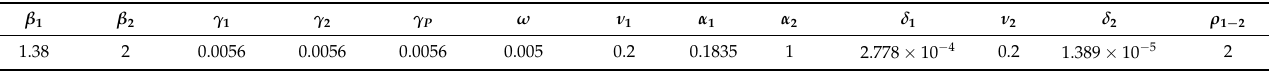
Table A6. Rate parameters used for Figure